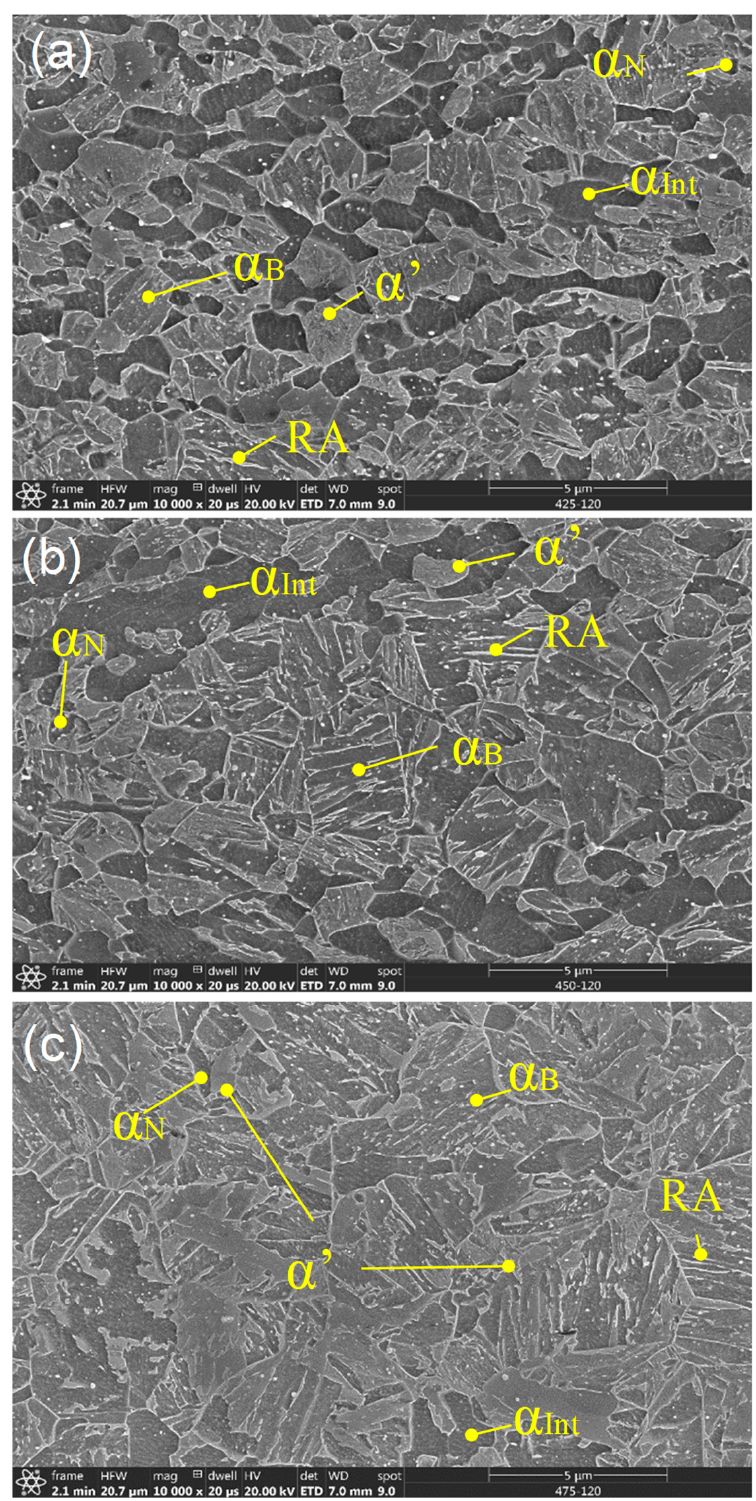
Figure 11. Images obtained by scanning electron microscopy on samples with 120 s of IBT at: ( a ) 425 °C, ( b ) 450 °C, and ( c ) 475 °C. α B = Bainite, α Int = Intercritical ferrite, α N = Pro-eutectoid (new) ferrite, RA = Retained austenite, and α ’ = Martensite. Table 2. Percentage of phases and microconstituents as a function of IBT time/temperature (vol. %).